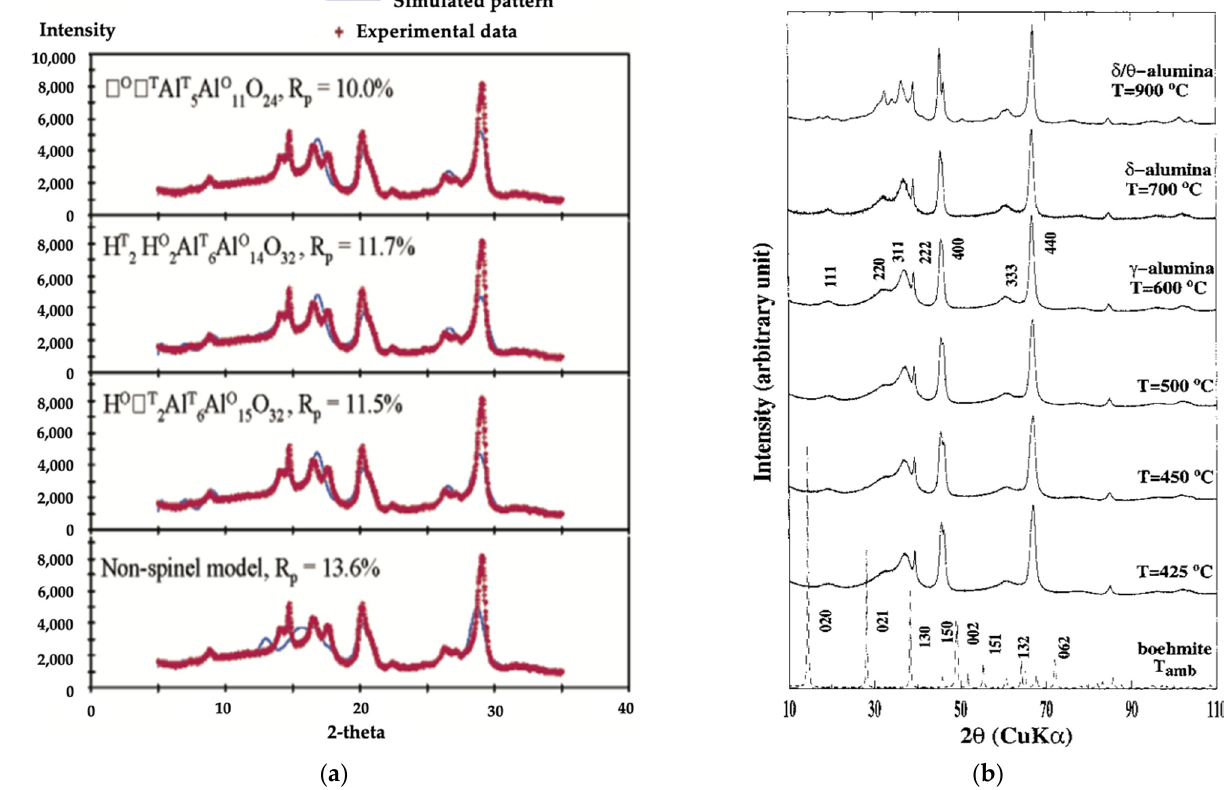
Figure 4. ( a ) Simulated (blue) XRD patterns for γ -alumina models compared with experimental (red) *; ( b ) Experimental XRD patterns for boehmite at different temperatures **. * Reprinted (adapted) with permission from Sun, M.; Nelson, A.E.; Adjaye, J. Examination of spinel and nonspinel structural models for γ -Al 2 O 3 by DFT and Rietveld refinement simulations. J. Phys. Chem. B 2006 , 110 , 2310–2317. Copyright 2006 American Chemical Society. ** Reprinted (adapted) with permission from Krokidis, X.; Raybaud, P.; Gobichon, A.-E.; Rebours, B.; Euzen, P.; Toulhoat, H. Theoretical study of the dehydration process of boehmite to γ‐ alumina. J. Phys. Chem. B 2001 , 105 , 5121–5130. Copyright 2001 American Chemical Society.